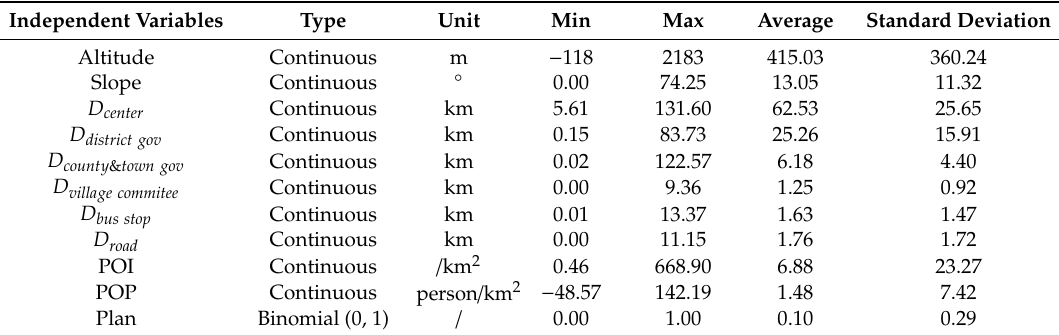
Table 2. Descriptive statistics of